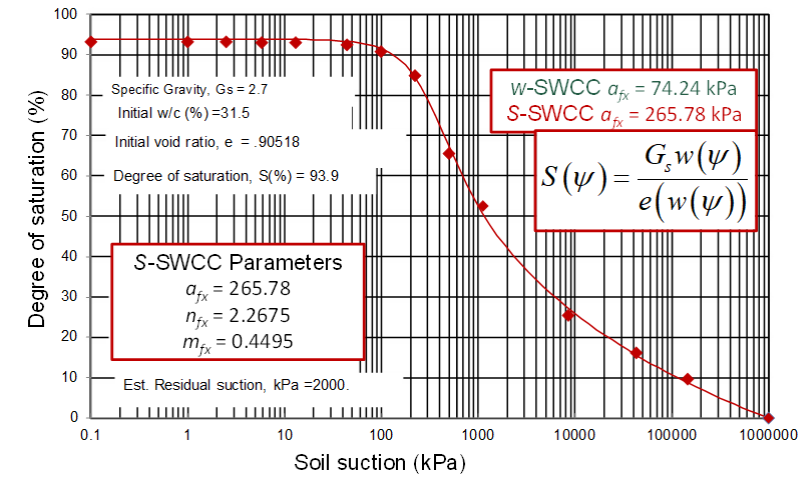
Figure 15. Graphical presentation of the S -SWCC regression analysis results.